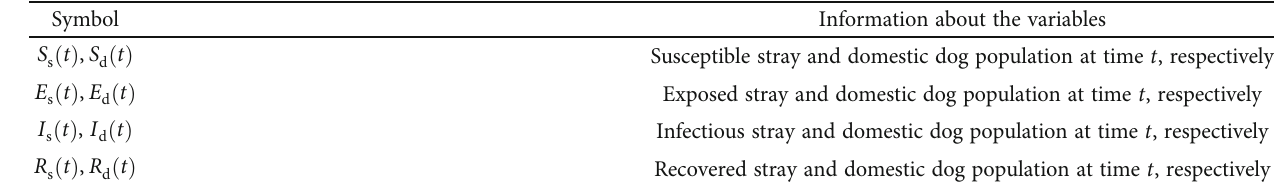
Table 1: Variables in the model and its explanation.